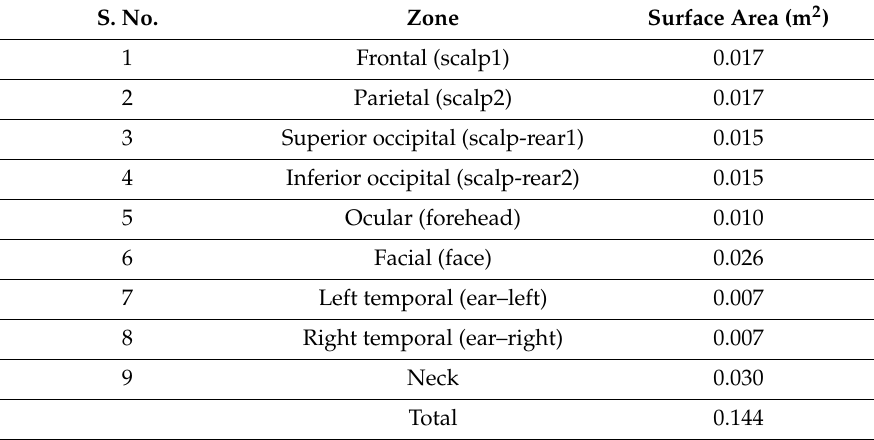
Table 2. Manikin measurement zone and surface